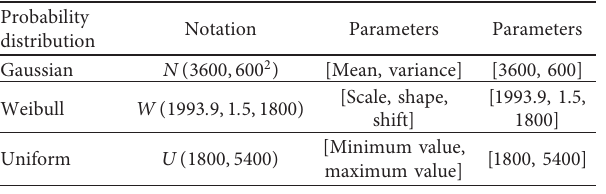
Table 5: Probability distributions and their parameters (in seconds).